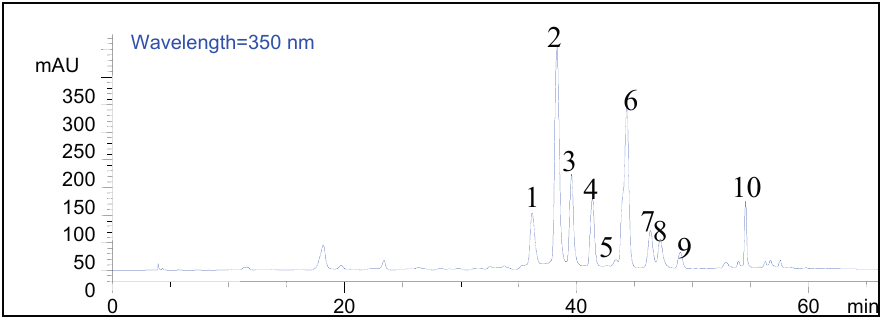
Figure 2. Four flavone aglycones in Chrysanthemum morifolium Ramat by HPLC-MS n analysis.